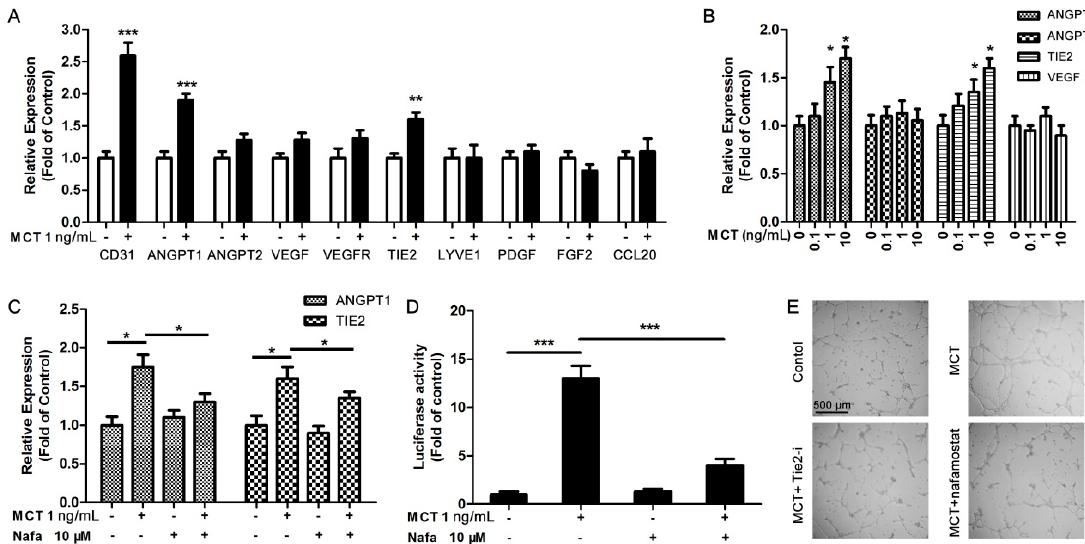
Figure 3. MCT activated HUVEC function via up-regulation of ANGPT1 pathway. ( A ) qPCR was used to detect the expression levels of angiogenesis-related gene expression in HUVEC treated with 1 ng/mL MCT for 2 h; ** p < 0.01, *** p < 0.001 compared to control, n = 3; ( B ) ANGPT1, ANGPT2, VEGF and TIE2 expression levels were further detected by qPCR in HUVEC cells after 2 h treatment with dose-dependent MCT. * p < 0.05 compared to control, n = 3; ( C ) After HUVEC were treated with MCT or along with nafamostat (Nafa) for 2 h, ANGPT1 and TIE2 expression levels were detected by qPCR. * p < 0.05 as indicated, n = 3; ( D ) The activity of luciferase reporter containing ANGPT1 promoter region was examined after treatment with MCT or combined with nafamostat for 2 h, *** p < 0.001, n = 3. All statistical difference were analyzed by ANOVA and Student-Newman-Keuls tests; ( E ) Tube formation assays were performed to determine the tube formation ability of 1 ng/mL MCT only, 1 ng/mL MCT and 10 µ M Tie2 inhibitor or 10 µ M nafamostat co-treated HUVEC. Scale bar = 500 µ m and refer to all panels.